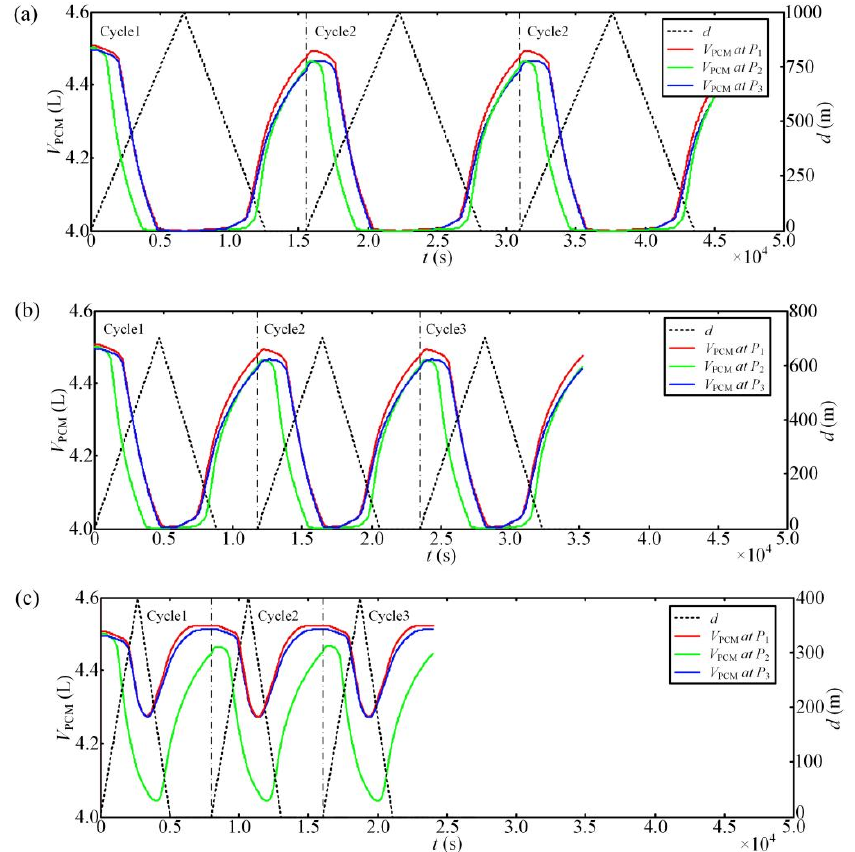
Figure 9. The variation of PCM volume with diving depth at different positions. ( a ) At the diving depth of 1000 m; ( b ) At the diving depth of 700 m; ( c ) At the diving depth of 400 m.